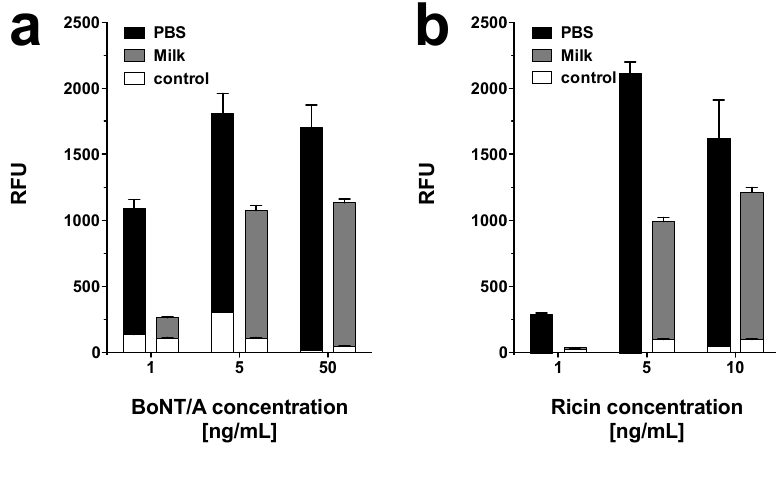
Figure 7. Dose response for BoNT/A and ricin in raw milk. PBS (black bars) and raw milk (gray bars) were spiked with different concentrations of ( a ) BoNT/A (1, 5, and 50 ng·mL − 1 ) and ( b ) ricin (1, 5, and 10 ng·mL − 1 ). Negative control values are depicted in white within the respective measurement. Average signal intensities and the standard deviation (error bars) were calculated from six features (n = 6) per